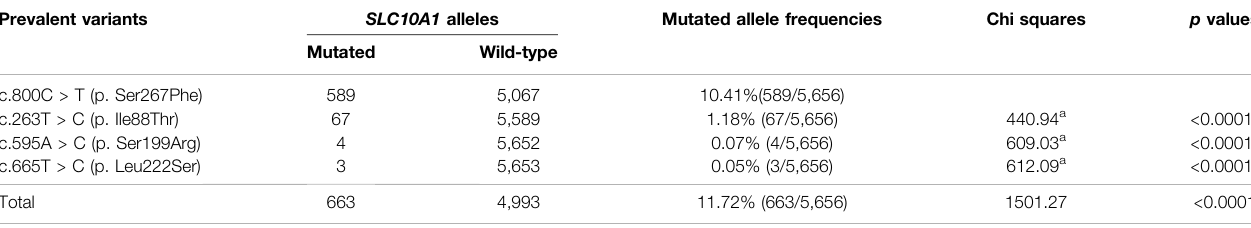
TABLE 2 | The allele frequency of the four prevalent SLC10A1 variants in Guangdong population. Prevalent variants